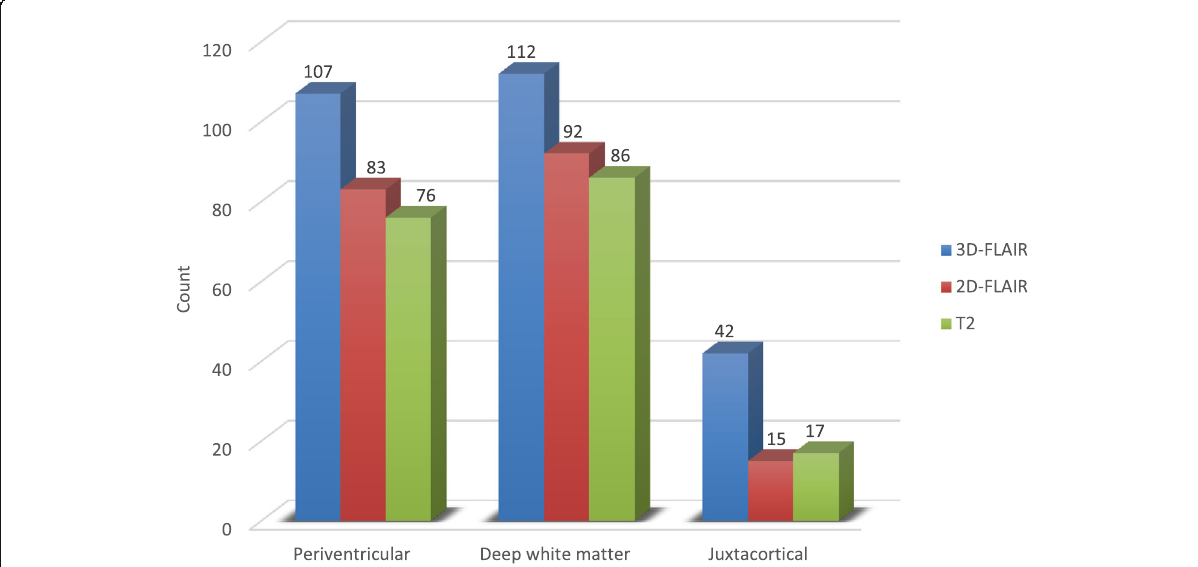
Fig. 7 Analysis of supratentorial white matter lesion detection by 3D-FLAIR, 2D-FLAIR, and T2WI according to their anatomical site (periventricular, deep white matter, and